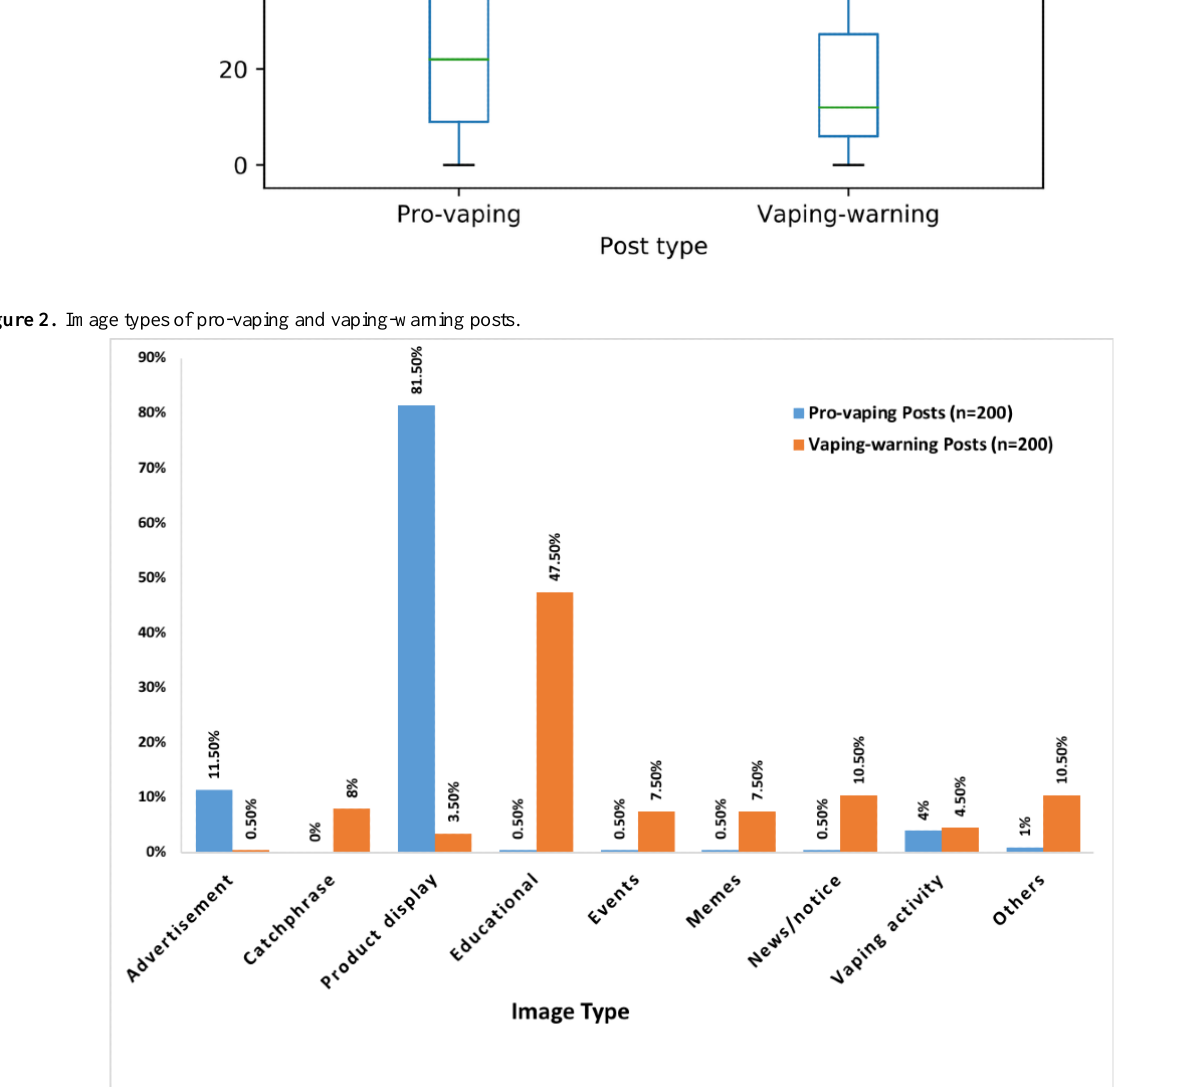
The number of hashtags for pro-vaping posts (mean 20) was significantly higher ( P< .001) than that for vaping-warning posts (mean 7) (Multimedia Appendix 4). As one of the essential metrics on social media, the top 20 hashtags used for each group of posts are shown in Table 1. Each hashtag used in the